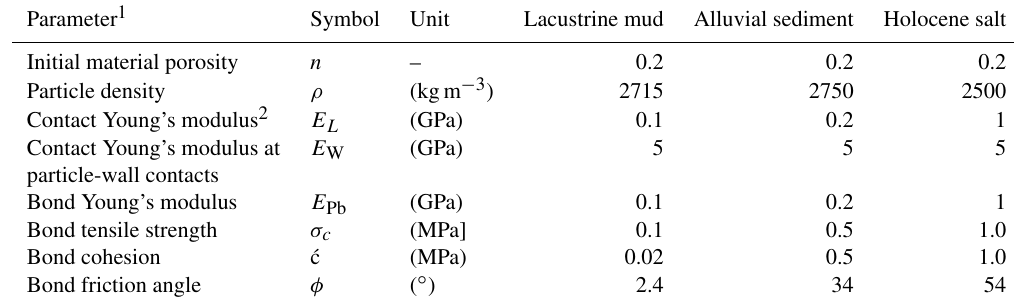
Table 3. Particle, contact and bond properties for DEM sinkhole collapse models. Note the geology convention.